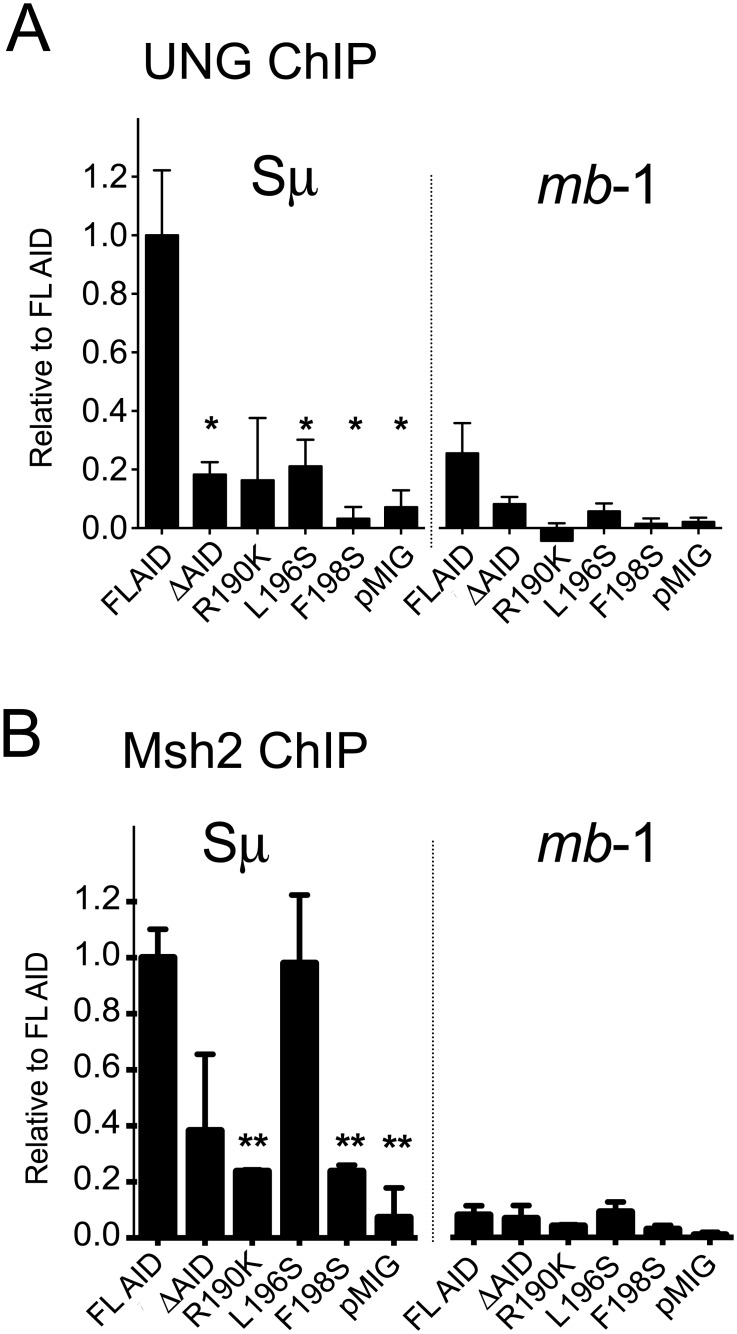
ChIP analyses demonstrate that untagged ΔAID and the substitution mutants poorly recruit UNG and Msh2 (except for L196S) to Sμ.ChIP for UNG (A) and Msh2 (B) at Sμ and at the mb1 gene in aid
-/- cells transduced with retroviruses expressing the indicated untagged AID proteins. Cells were induced to switch to IgG3, transduced 1 day after activation, and harvested 2 days later. ChIPs were analyzed by qPCR; % input was calculated, and % input in absence of antibody was subtracted. Results are normalized for each set of mutants to binding results for FL-AID at Sμ for each experiment. Error bars indicate SEM. Three independent experiments with duplicate IPs were performed, except for R190K and F198S, for which one experiment with duplicate IPs was performed, and then the range is indicated. p values for difference from FL-AID were determined by an unpaired 2-tailed T test. *p ≤0.01; **p<0.001. p value for ΔAID in Msh2 ChIP = 0.076.